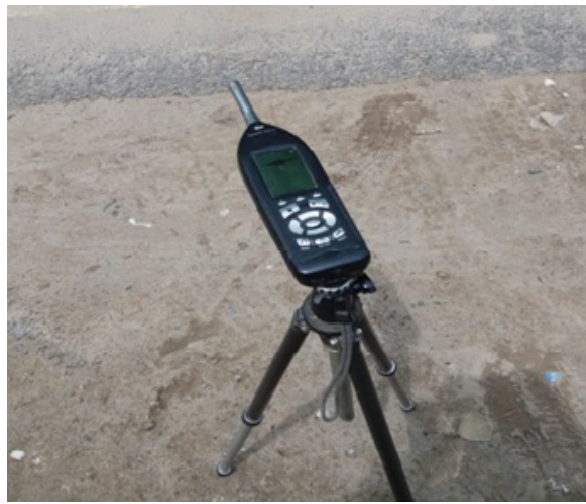
Figure 2: Sound Level Meter Larson and